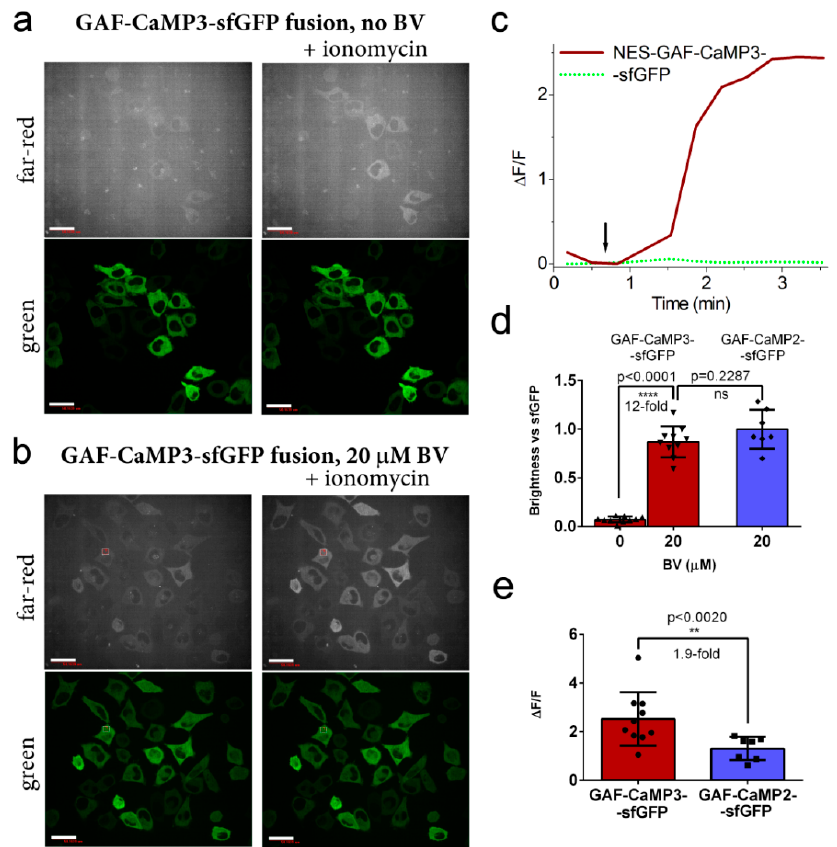
Figure 3. Optimization of the expression of the GAF-CaMP3–sfGFP indicator and its response to Ca 2+ variations in HeLa cells. Confocal images of the HeLa cells expressing the nuclear export signal - (NES)-GAF-CaMP3–sfGFP fusion calcium indicator in the absence (a) and in the presence of 20 µM of external BV (b) before and after the addition of 2.5 µM of ionomycin. ( a,b ) Far-red and green fluorescence channels correspond to Ex 640 nm/Em 685/40 nm and Ex 488 nm/Em 525/50 nm, respectively. Scale bar, 50 µm. (c) The graph illustrates Δ F/F changes in green and far-red fluorescence of the GAF-CaMP3–sfGFP indicator in response to the addition of 2.5 µM of ionomycin. The changes in the graph correspond to the area indicated panel (b). (d) Comparison of averaged brightnesses for the GAF-CaMP3–sfGFP and GAF-CaMP2–sfGFP indicators in the HeLa cells upon the addition of 2.5 µM of ionomycin in the absence and in the presence of 20 µM of BV. (e) Comparison of the averaged Δ F/F responses for the GAF-CaMP3–sfGFP and GAF-CaMP2–sfGFP indicators in the HeLa cells upon the addition of 2.5 µM of ionomycin in the presence of 20 µM of BV. ( d,e ) Error bars are the standard deviations across 7–10 cells. The p -values show statistical difference between the respective values. p values ≤ 0.0001 and ≤ 0.01 are given four (****) and two (**) asterisks, respectively. Ns, not significant. BV (20 µM) was added 24 h before imaging.